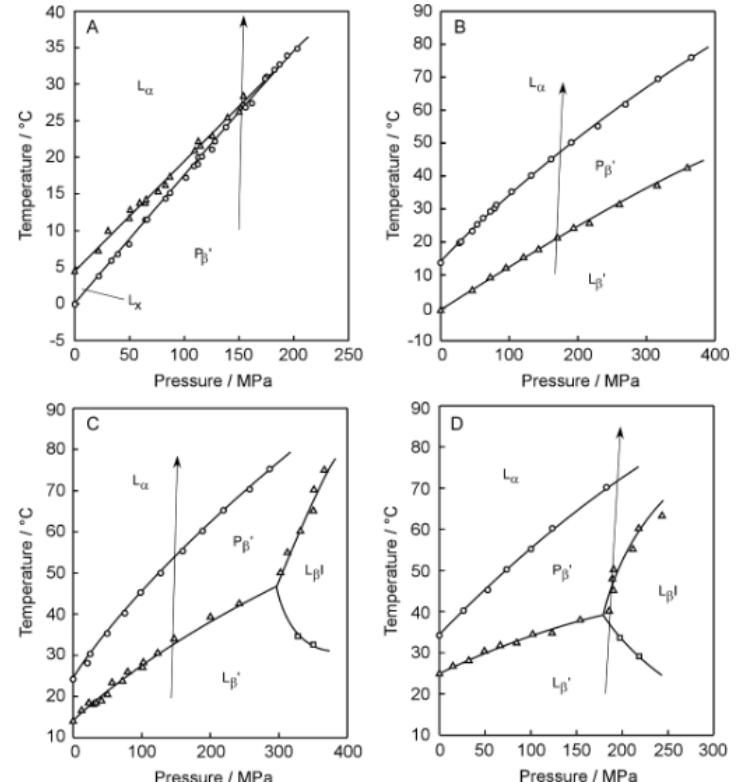
Figure 3. Temperature ( T )–pressure ( P ) phase diagrams of the C n PC bilayer membranes ( n = 12–15): ( A ) C12PC, ( B ) C13PC, ( C ) C14PC, ( D ) C15PC. The arrow shown in each diagram indicates the